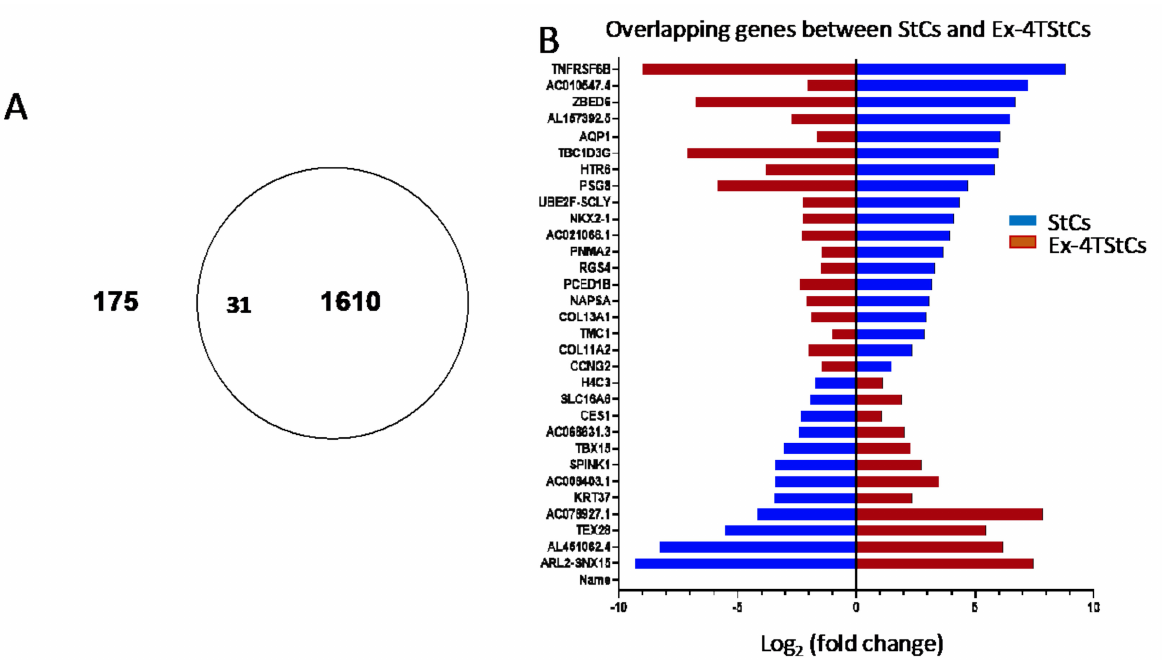
Figure 5. Venn diagram ( A ) and bar graph ( B ) depicting the overlapped DEGs between steatotic cells and Exendin-4 treated steatotic HepG2 cells. The blue color indicates downregulation, while the magenta color indicates